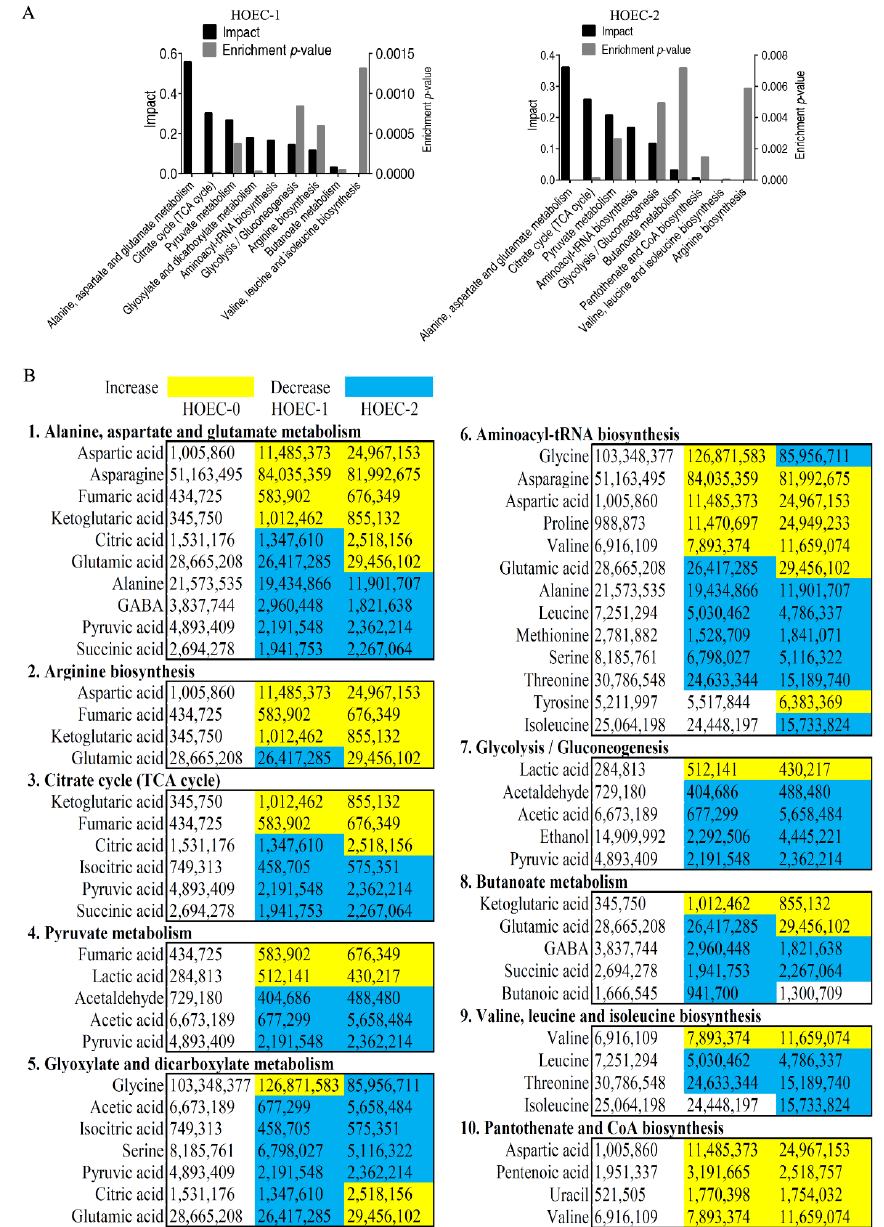
Figure 7. Pathway enrichment analysis of differential metabolites in HOEC cells after cisplatin treatment. Significantly enriched metabolic pathways ( A ). The abundance of metabolites in the enriched metabolic pathway ( B ). HOEC-0, HOEC-1 and HOEC-2 represent the HOEC cells treated with cisplatin for 0 h, 24 h or 48 h.